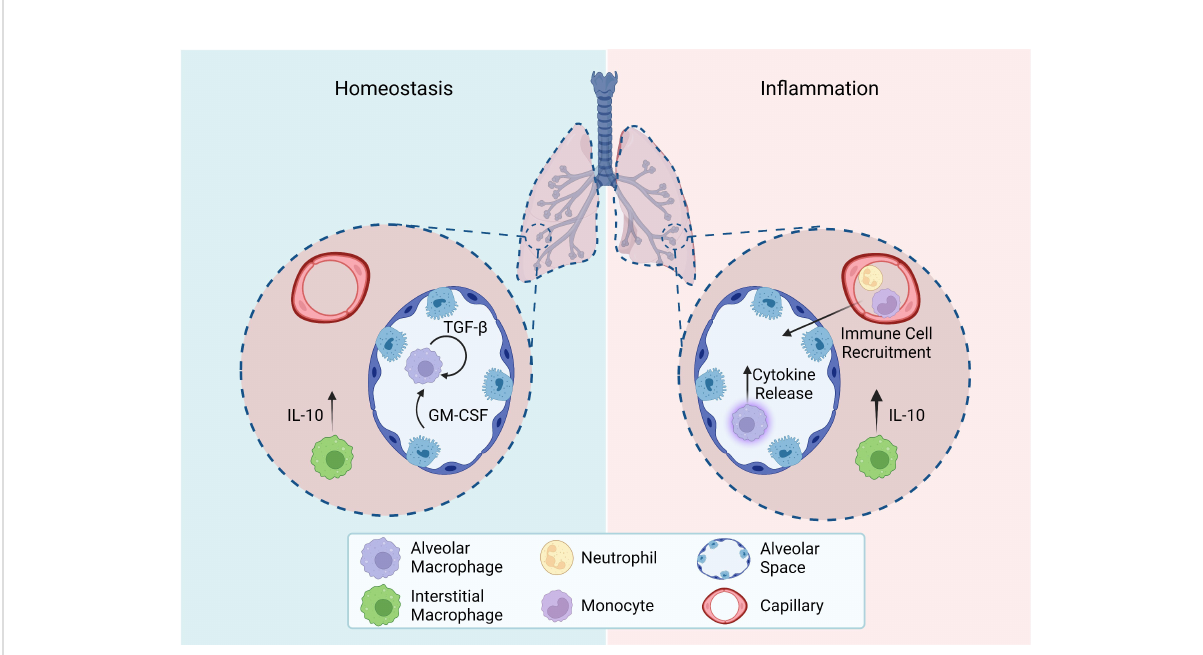
FIGURE 4 Homeostasis and in fl ammation in the lung. Roles of tissue-resident macrophage subsets in the lung during homeostasis and in fl ammation. Homeostasis: Alveolar macrophage maintenance relies on autocrine TGF- b and epithelial cell release of GM-CSF. Interstitial macrophages constitutively release IL-10. In fl ammation: Activated alveolar macrophages release cytokines to recruit other immune cells and promote an in fl ammatory response. Interstitial macrophages upregulate their release of IL-10. All fi gures were created with BioRender.com